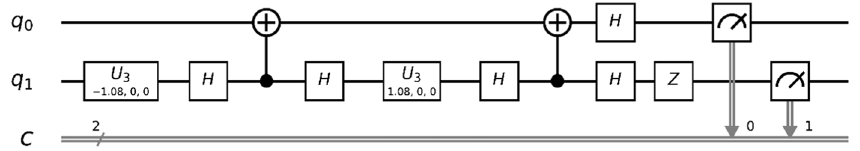
as used in the IBM simulator and quantum device. For a full M 1 0